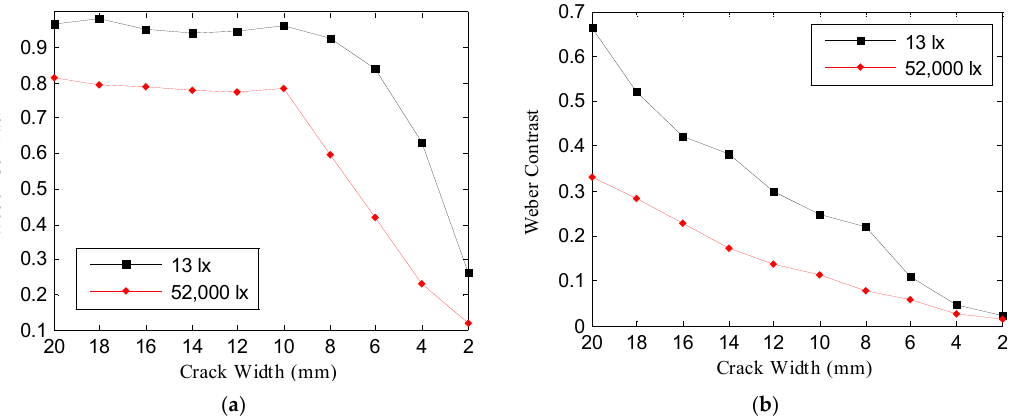
Figure 16. Comparison of Weber contrast of crack images acquired at 13 lx and 52,000 lx, Shooting distance: ( a ) 25 m, ( b ) 100 m.